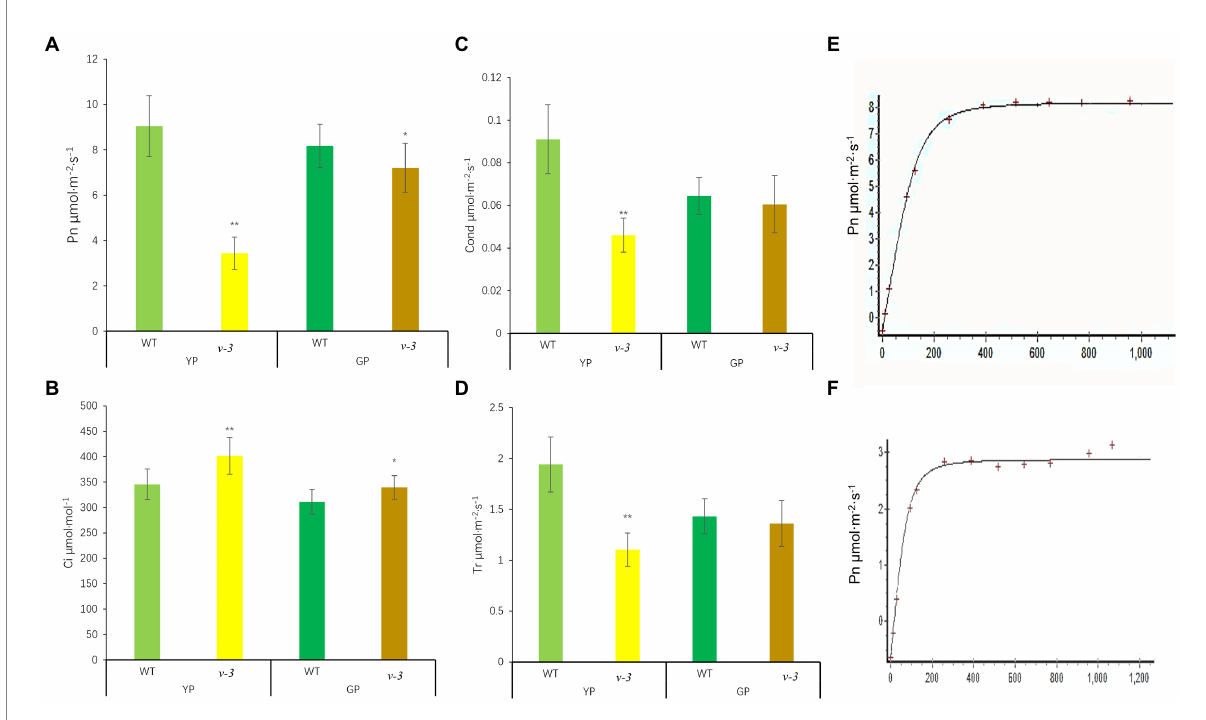
FIGURE 4 Photosynthetic parameters of v-3 and the WT in yellowing period (YP) and turning green period (GP). (A) Net photosynthetic rate (Pn); (B) Intercellular CO 2 concentration (Ci); (C) Stomatal conductance (Gs); (D) Transpiration rate (Tr); (E) light response curve of WT; (F) light response curve of v-3 ; Values are the mean ± SD. SD, standard deviation; WT, wild type. * p < 0.05. ** p <